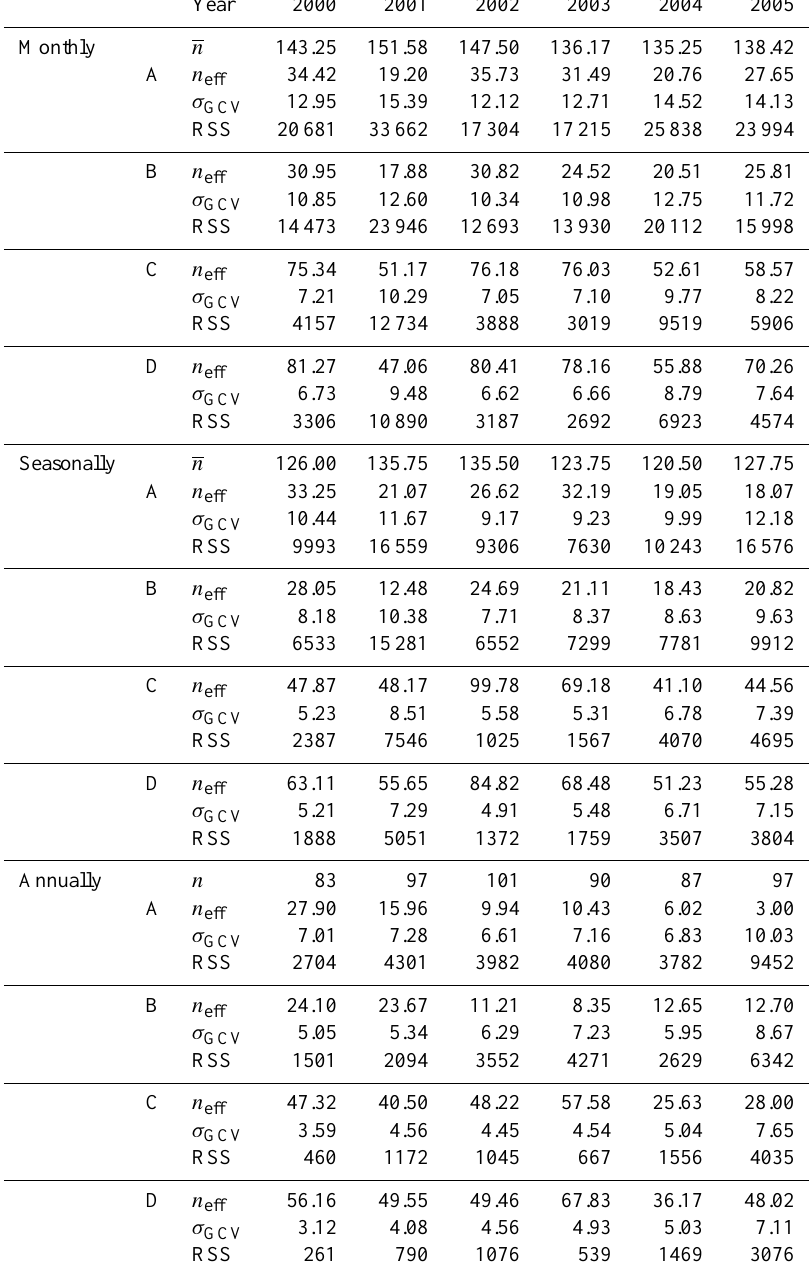
Table 4. Generalized cross-validation error ( σ GCV ) and residual sum of square (RSS) for different strategies over 2000–2005. Monthly and seasonally results are averaged over each year, and annual results are directly estimated using annual means from each